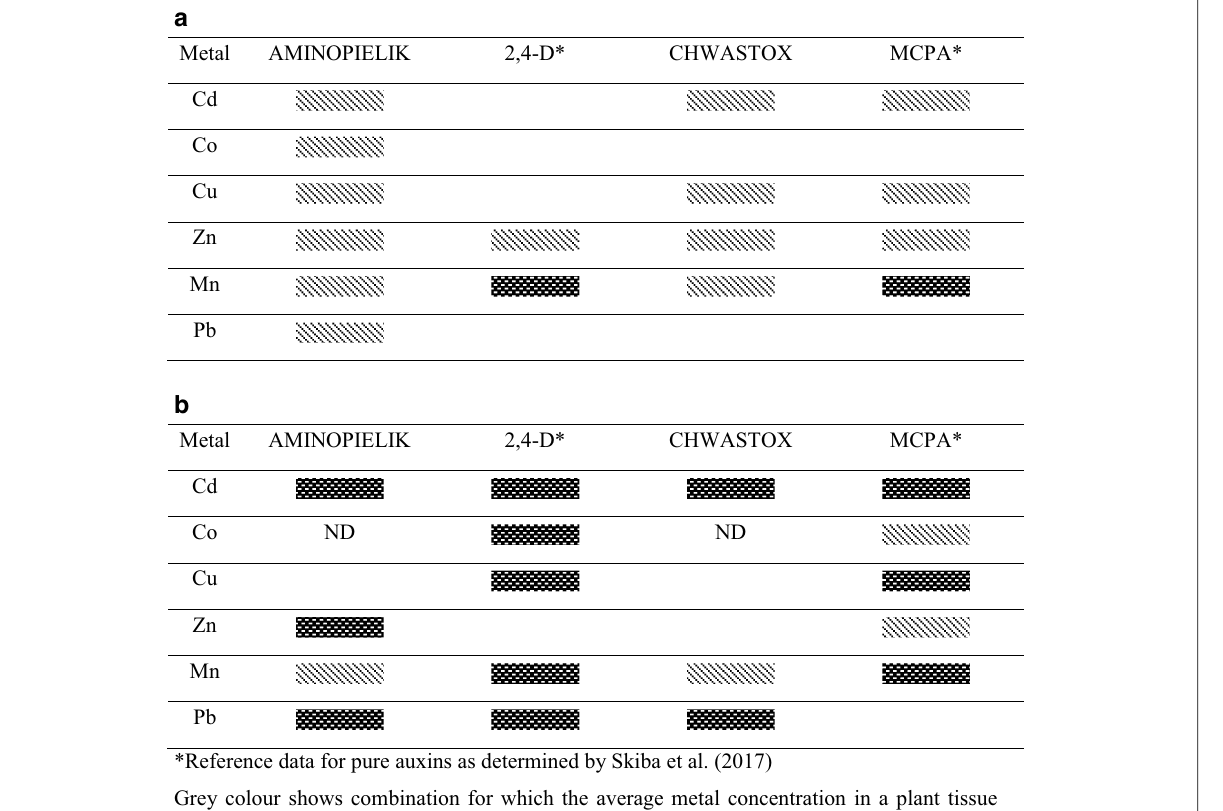
file 2: Table S2. Aminopielik elevated concentrations of all metals in roots while 2,4-D was successful for zinc only.